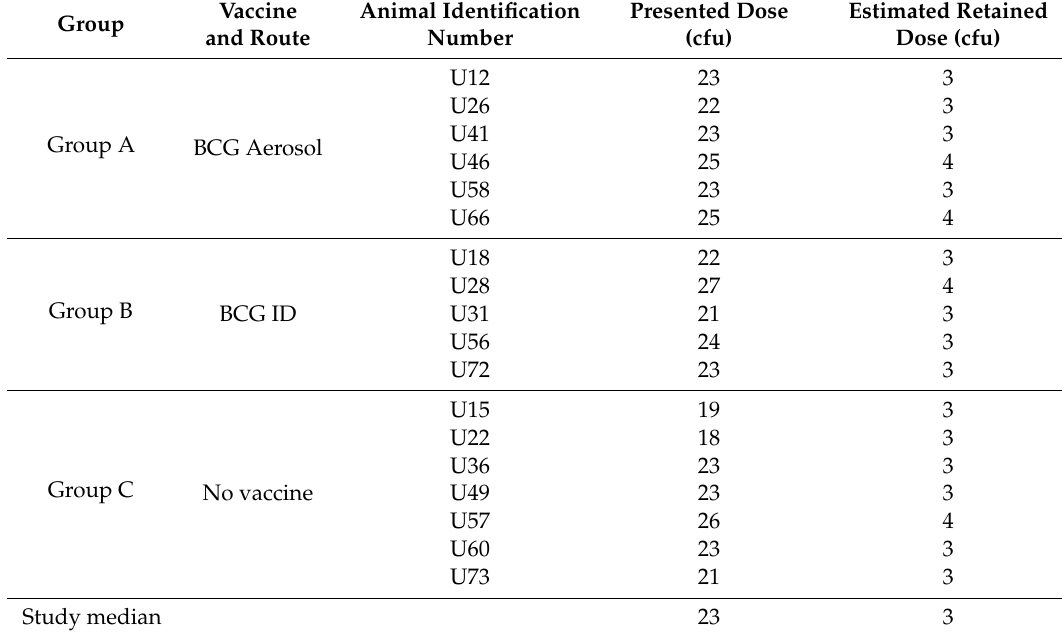
Table 1. Aerosol challenge doses of M. tuberculosis delivered to rhesus